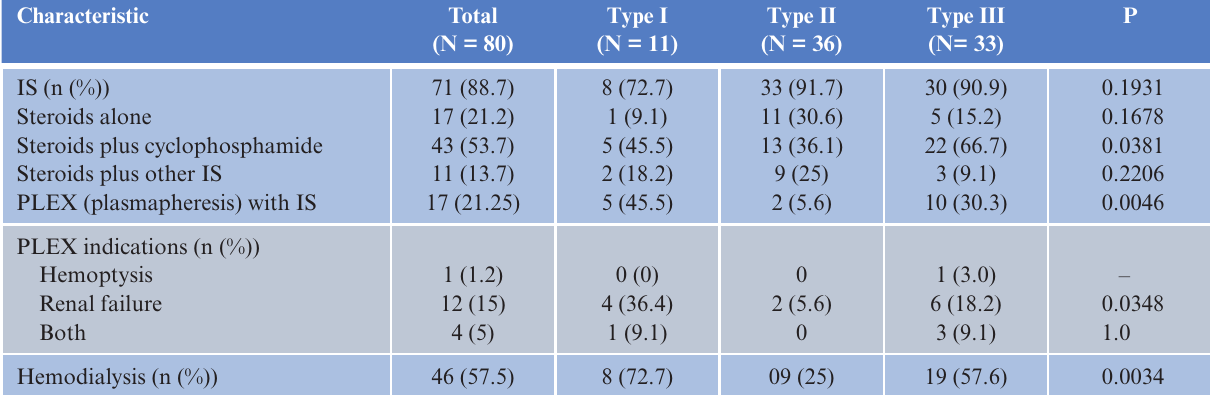
Table 4: Treatment characteristics of the study population.